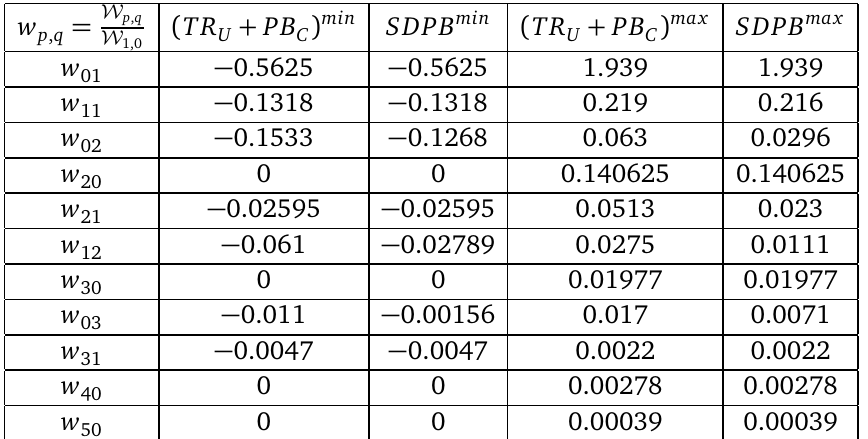
Table 2: A comparison of the values obtained using our results up to n = 5 and SDPB in [ 5 ] .We used the locality constraints and the techniques of [ 5 ] adapted using linear programming to generate the SDPB values quoted above. These are identical to the ones quoted in [ 5 ] . The exact agreement between these values is a consequence of the fact that the locality and null constraints are equivalent as observed in [ 30 ]